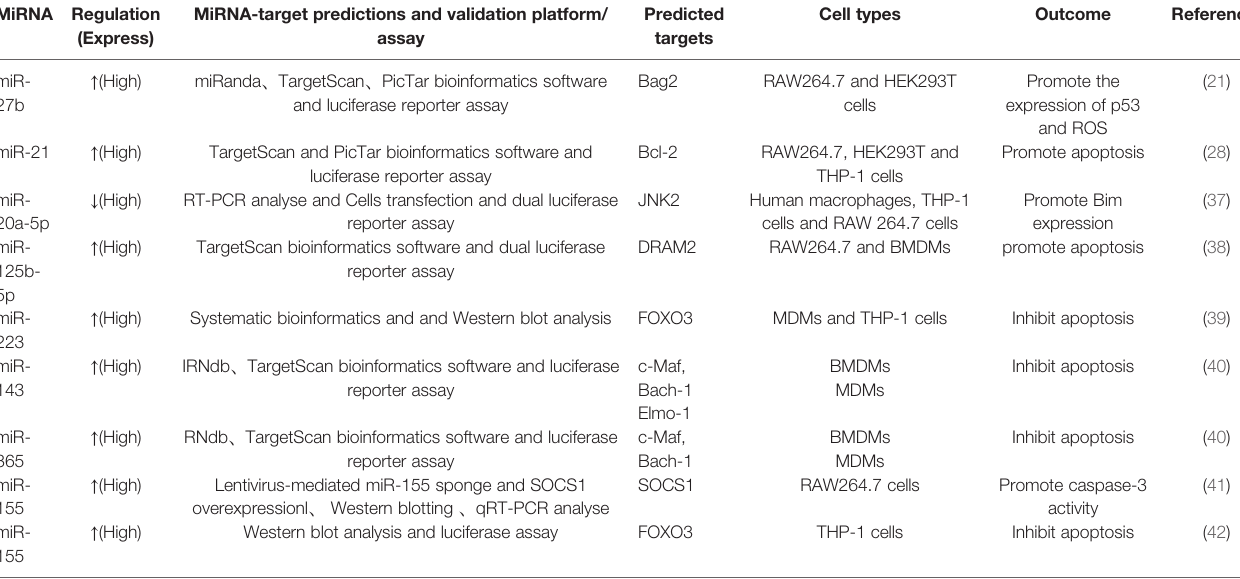
TABLE 2 | MiRNA-mediated regulation of apoptosis during M. tuberculosis